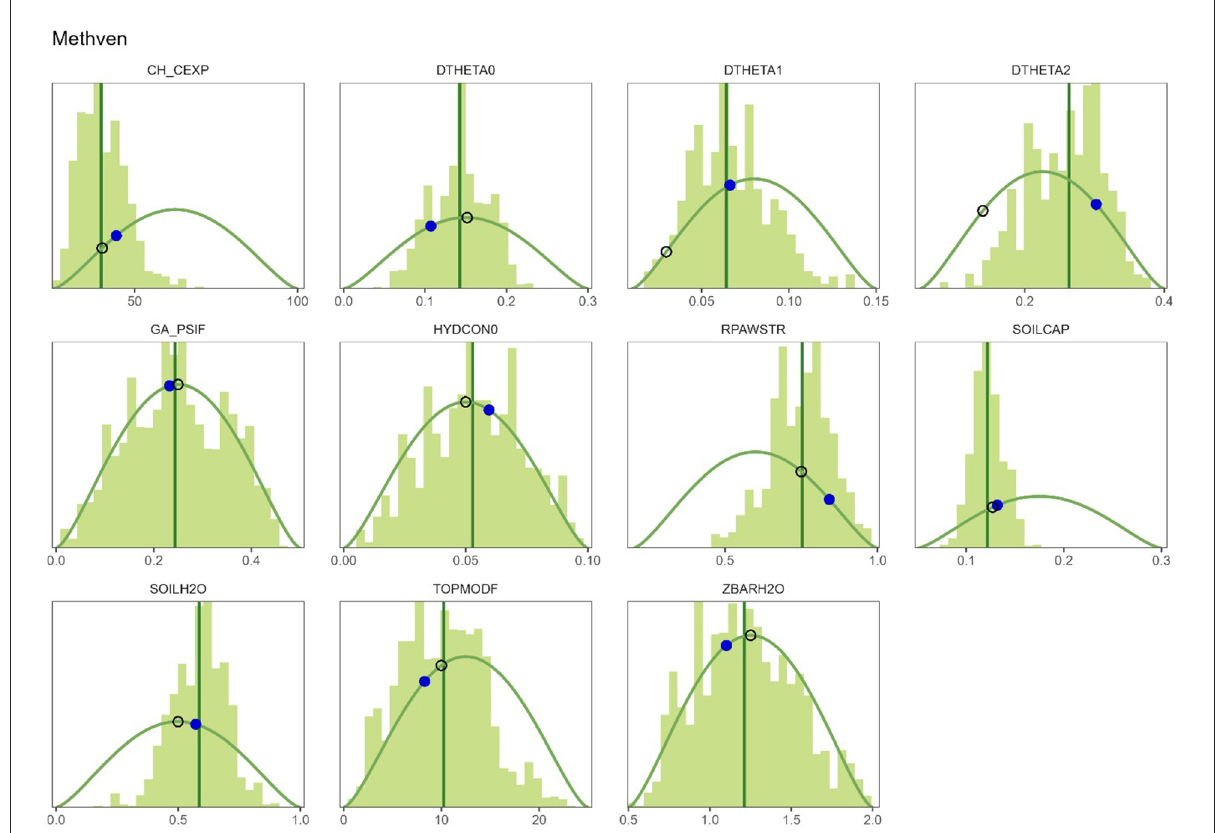
FIGURE8 Calibration to Methven data. Parameter (see Table 1) prior distributions (dark green curve), marginal posterior distributions (light green vertical bars), median values (dark green line), maximum a posteriori (MAP) values (blue dot) and upscaled values (black circle). The X -axis units for each subplot are given in Table 1 and the Y -axis is